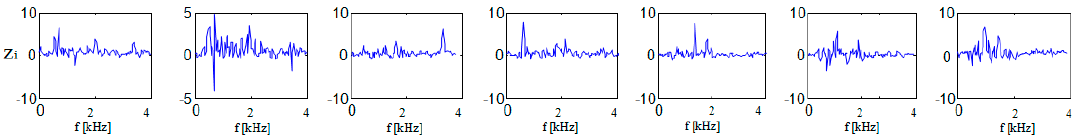
Figure 2. Spectrograms of constituent signals, ( a ) S1—ringer; ( b ) S2— baby and ( c ) the mixed signal S1+S2.